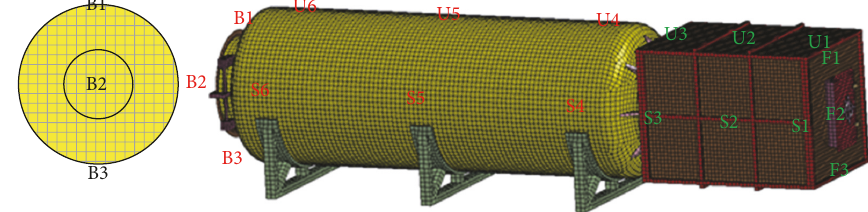
Figure 7: Pressure monitoring points distribution of the rescue capsule.